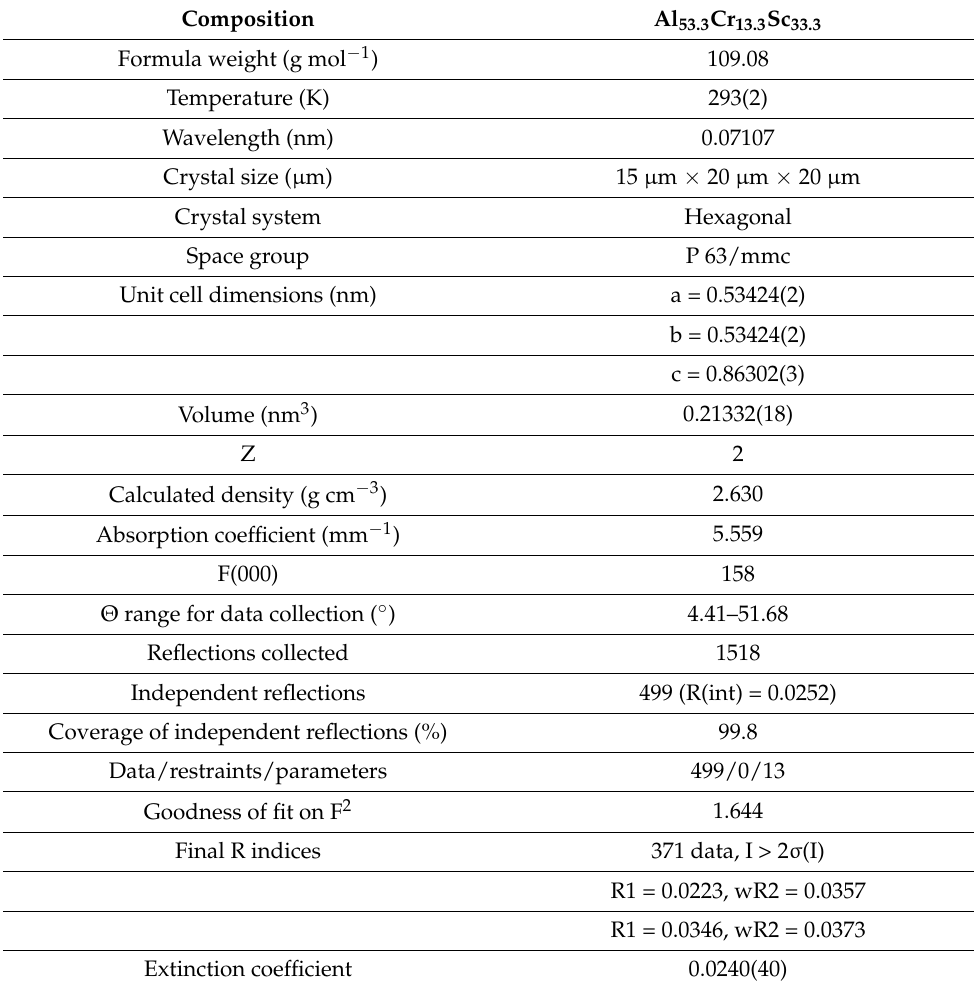
Table 4. Crystallographic data and structure refinement parameters * for the Al 2 − x Cr x Sc hexagonal phase, as determined from the single-crystal